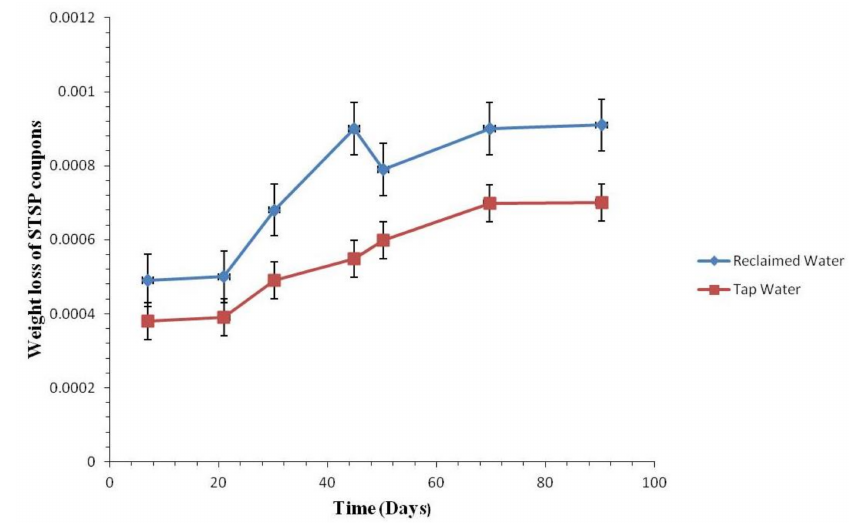
Figure 14. Weight loss of stainless steel pipe coupons with RW and TW over time with standard error